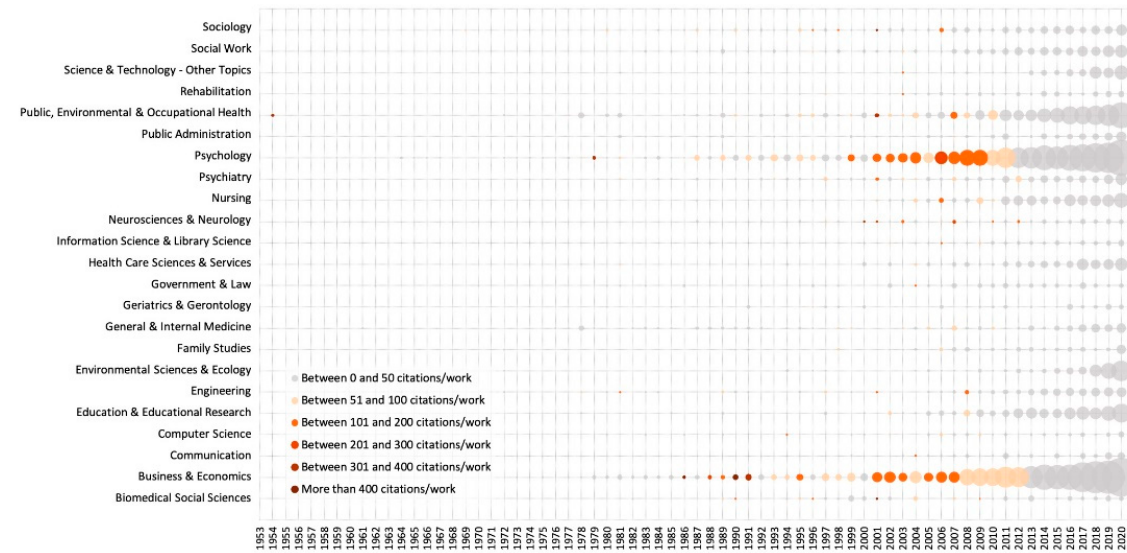
Figure 3. WoSCC scientific categories in POP research. Note: X-Axis: Publication year, Y-Axis: Scientific category, Bubble Size: number of works, Colors: citations/work.